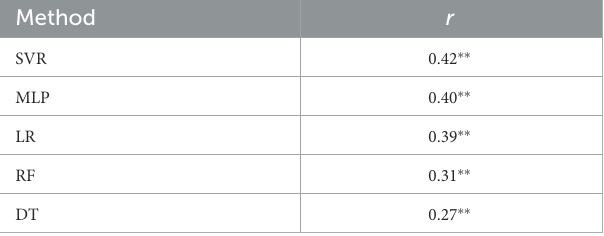
TABLE 4 Pearson correlation coefficients between the predicted scores and the questionnaire scores of life satisfaction.